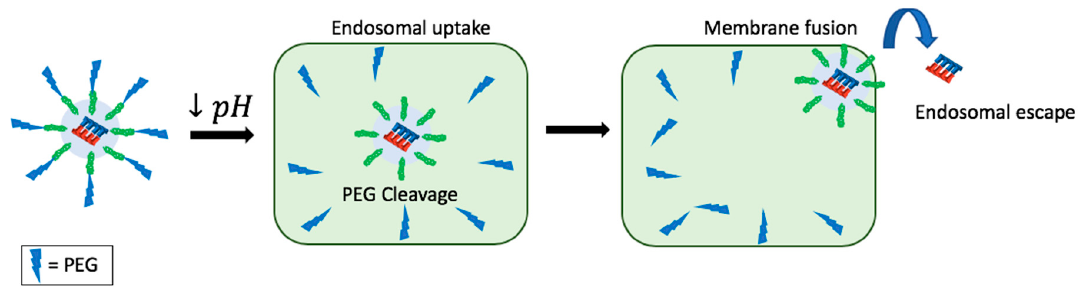
Figure 6. Mechanism of action of PEG-based cleavable polymeric system that responds to decreased pH in the endosomal environment.